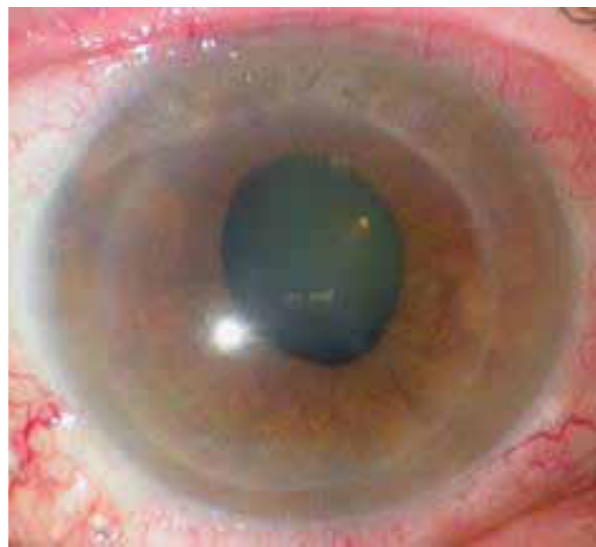
Figure 3 . Acute angle closure glaucoma showing oval shaped pupil, corneal haziness and loss of red reflex [Image available from https://